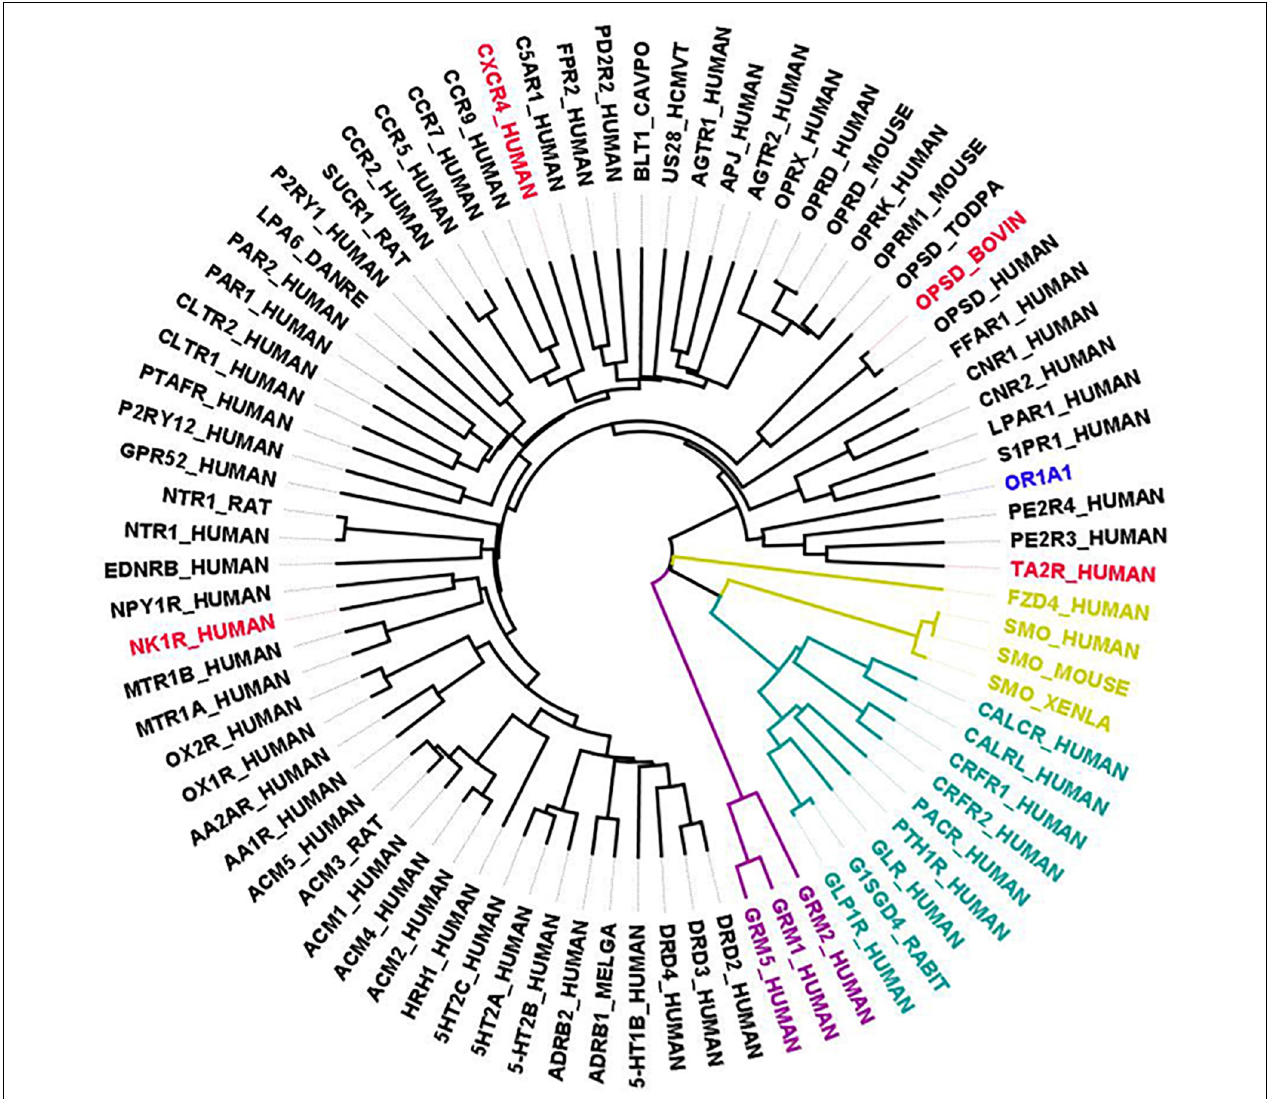
FIGURE 3 | Phylogenetic tree showing all available GPCR templates are distantly related to OR1A1. The selected templates for OR1A1 are shown in red color, members having known structures for class A are in black, Class B1 are in green color, Class C are in purple, and Class F are in gold color.